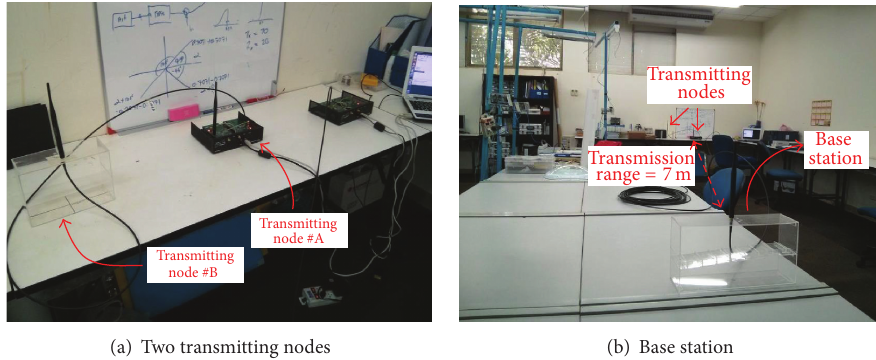
Figure 11: The configuration of the experiment on received signal